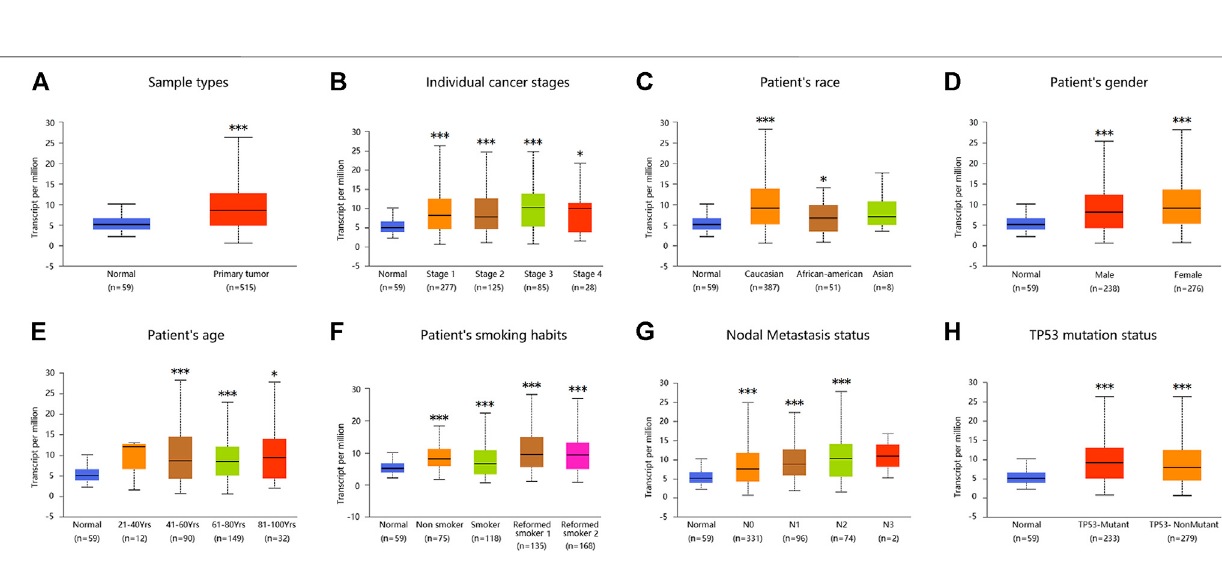
Frontiers in Molecular Biosciences |